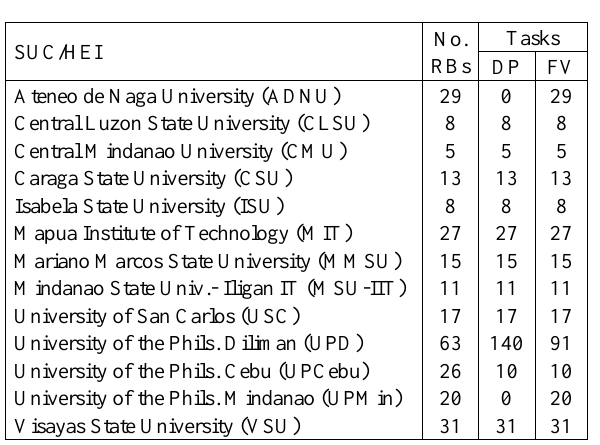
Figure 2. The PHD Project’s general workflow